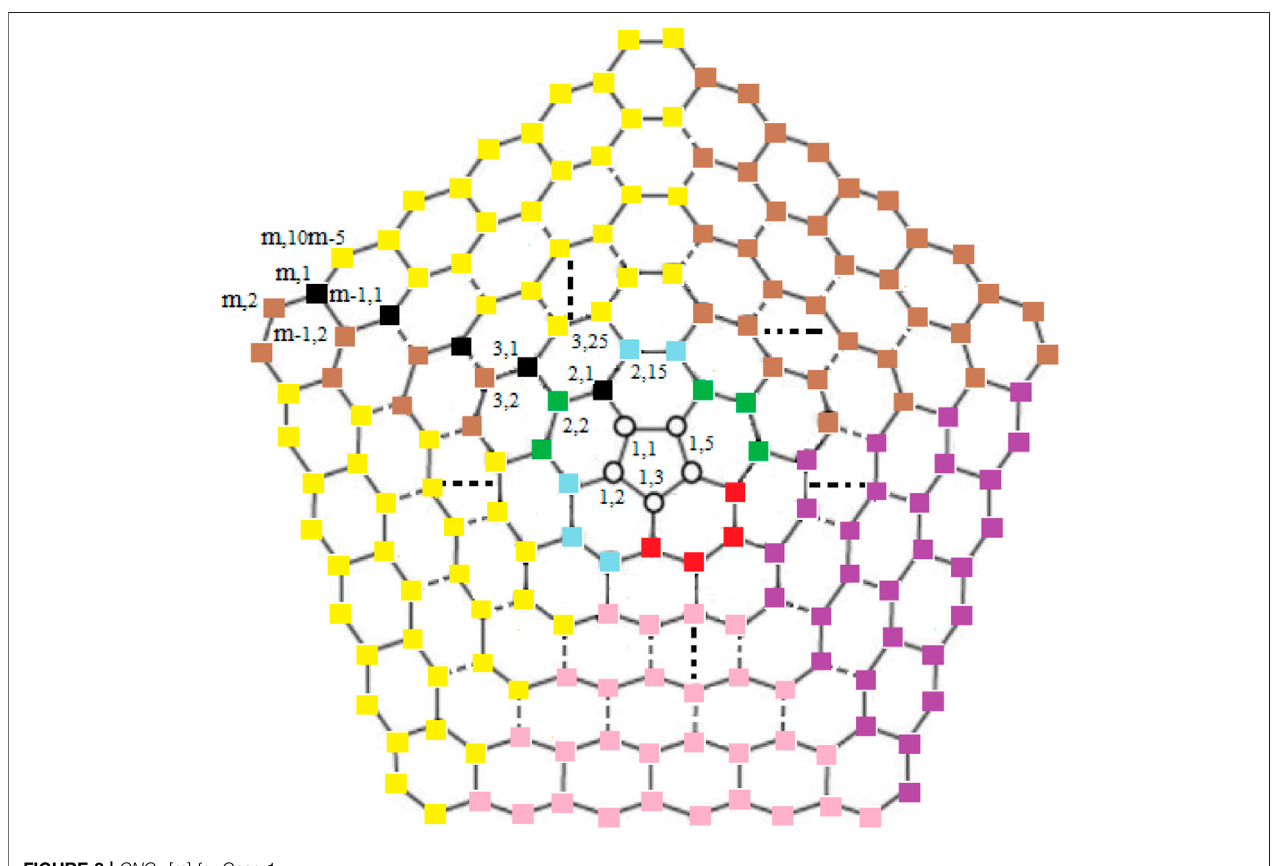
FIGURE 3 | CNC 5 [m] for Case 1.